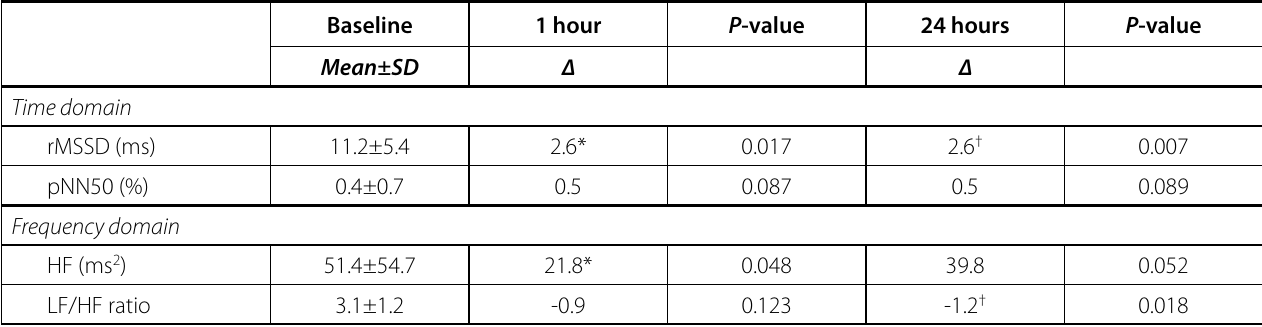
Table 2. Comparison between autonomic cardiac control measurements at baseline and at one hour and 24 hours after AES